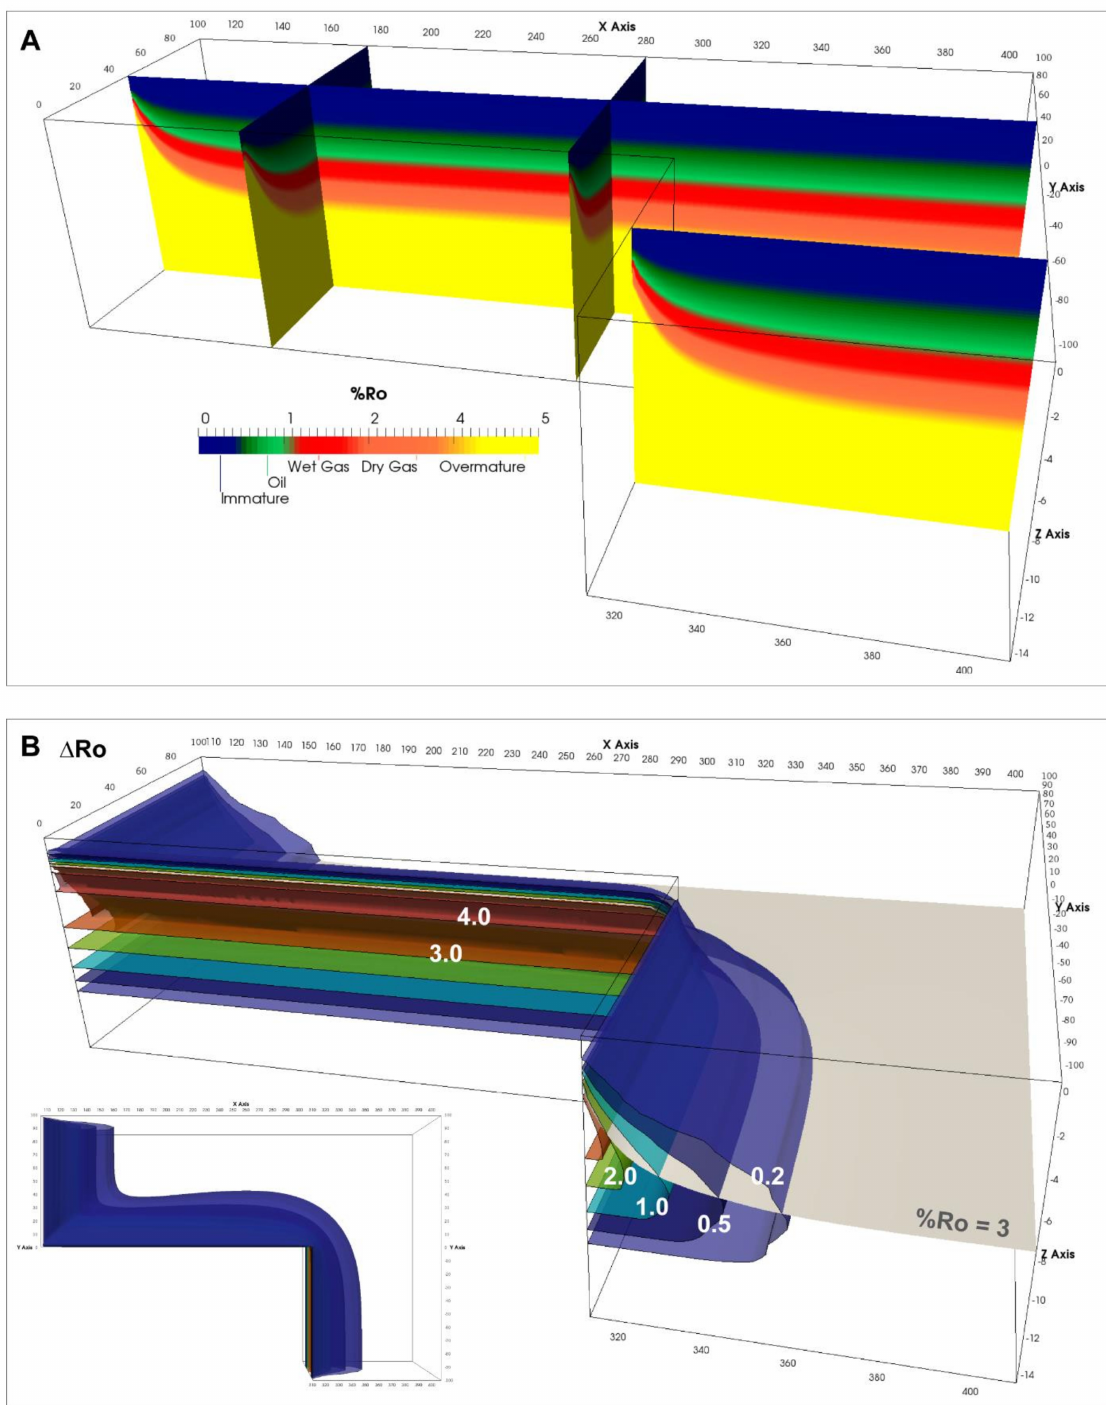
Figure 7. ( A ) Thermal maturity of sediments within the continental block at the end of Stage A. ( B ) Increase in thermal maturity of sediments within the continental block at the end of Stage A due to heat contribution from the spreading centers only. The thermal maturity isosurface at the onset of dry gas (%Ro = 3) is also shown. Inset shows top view. Note that the Z-axis is restricted to the upper 15 km and vertically